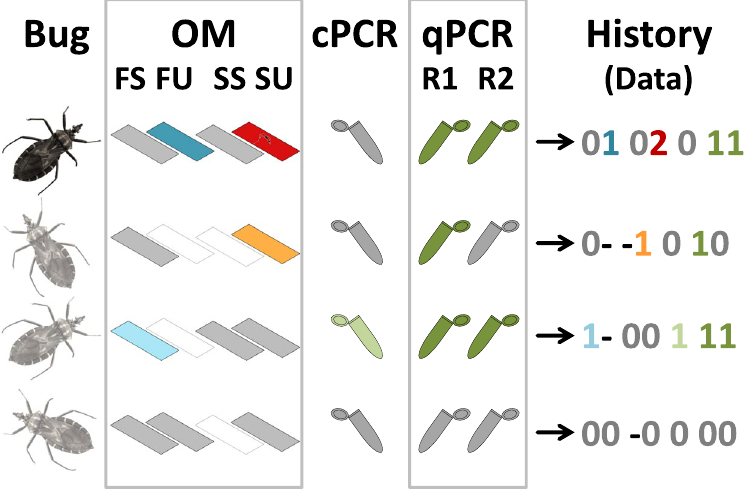
Figure 1. Detecting Trypanosoma cruzi in field-caught vectors. The figure illustrates our strategy of repeatedly checking for infection using (i) optical microscopy (OM) including slides read in routine surveillance (fresh, FS; Giemsa-stained, SS) or at the University of Brasília (fresh, FU; Giemsa-stained, SU), (ii) a conventional PCR (cPCR), and (ii) a replicate quantitative PCR (qPCR R1 and R2). Blank ‘slides’ represent OM slides that were not prepared for a given bug (coded ‘ − ’); in grey, tests that were scored as negative with ambiguity (possible false negatives, coded ‘0’); in light blue, dark blue, orange, light green, and dark green, tests scored as positive with ambiguity (possible false positives, coded ‘1’); and, in dark red with a parasite, a slide scored as positive without ambiguity (only when a professional parasitologists of the University of Brasília unmistakably identified T . cruzi trypomastigotes in a Giemsa-stained slide, coded ‘2’). The last column shows, for each bug, the “detection history” we used to construct our database, using the codes (‘ − ’, ‘0’, ‘1’, and ‘2’) defined above. Of the